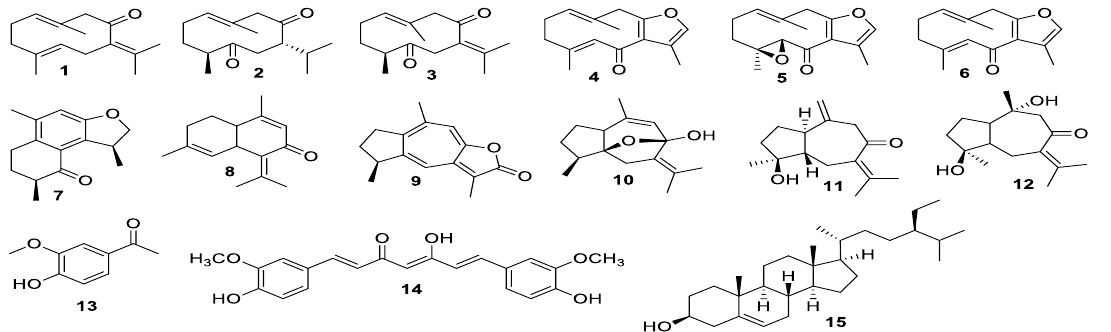
Figure 1. Structures of compounds isolated from C. aromatica rhizome.